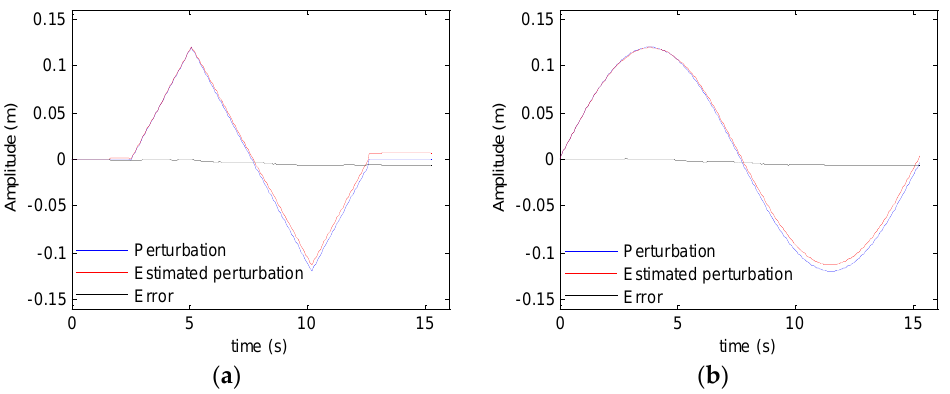
Figure 19. Estimation of motion error: ( a ) sawtooth perturbation; ( b ) sinusoidal perturbation.